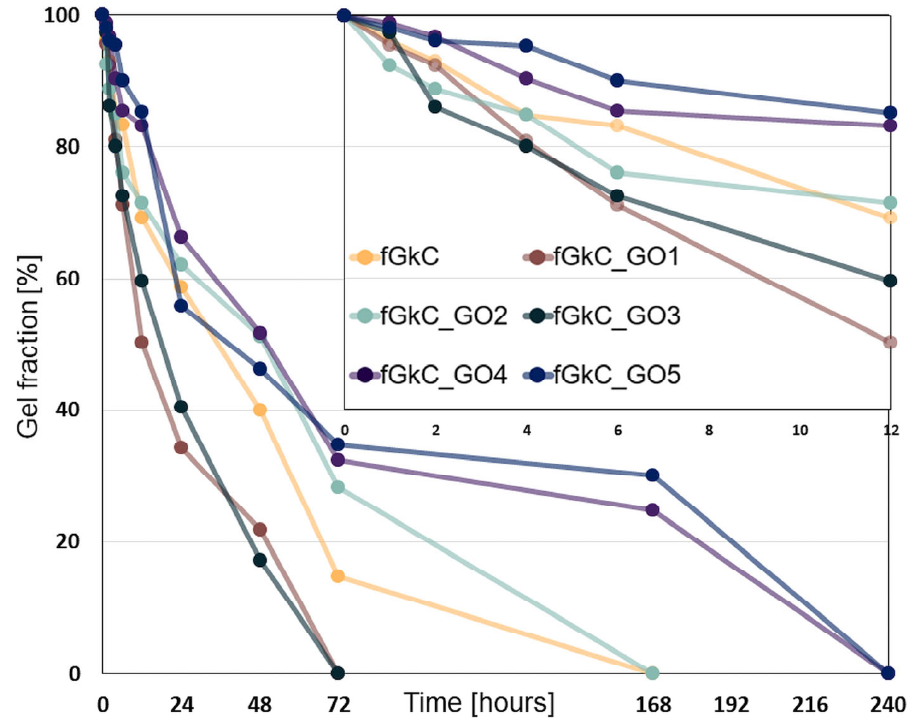
Figure 6. Gel fraction of the 6 formulations based on fish gelatin and k-carrageenan reinforced with graphene oxide after various times of incubation in collagenase solution.